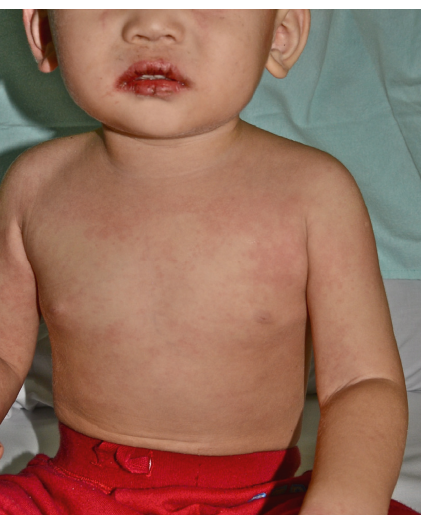
Figure 1: A 20-month-old boy with Kawasaki disease presenting with red cracked lips and an erythematous maculopapular rash on the anterior chest and upper arms.